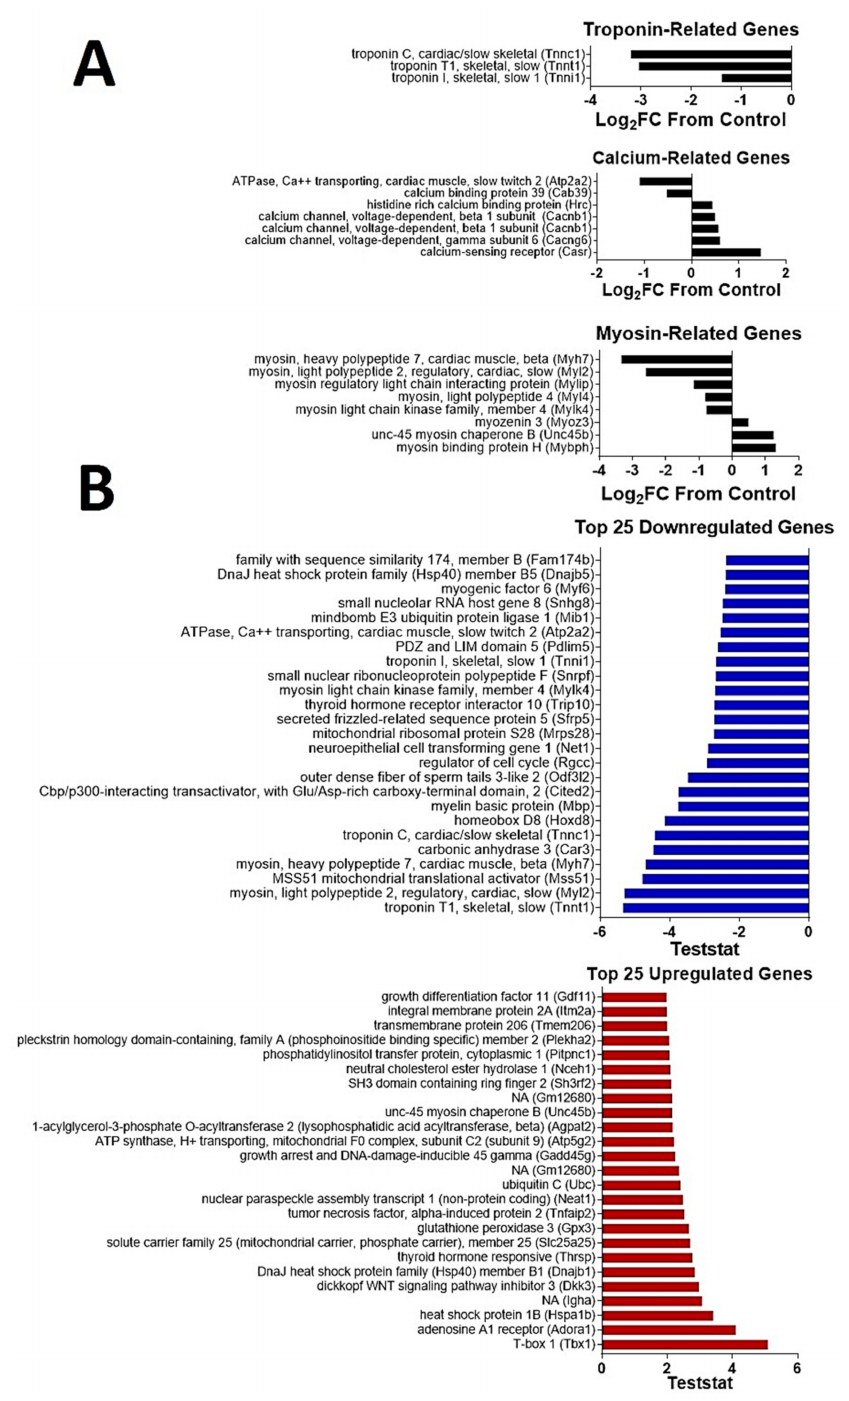
Figure 6. Changes in gene signature with CDN1163 treatment. Ingenuity pathway analysis showing the alterations in the expressions of genes related to troponin, calcium regulation and myosin ( A ) as well as the top 25 up- and down-regulated genes ( B ) in the gastrocnemius muscles of CDN1163-treated 26-month old mice, when compared to vehicle treated mice ( n = 8–9